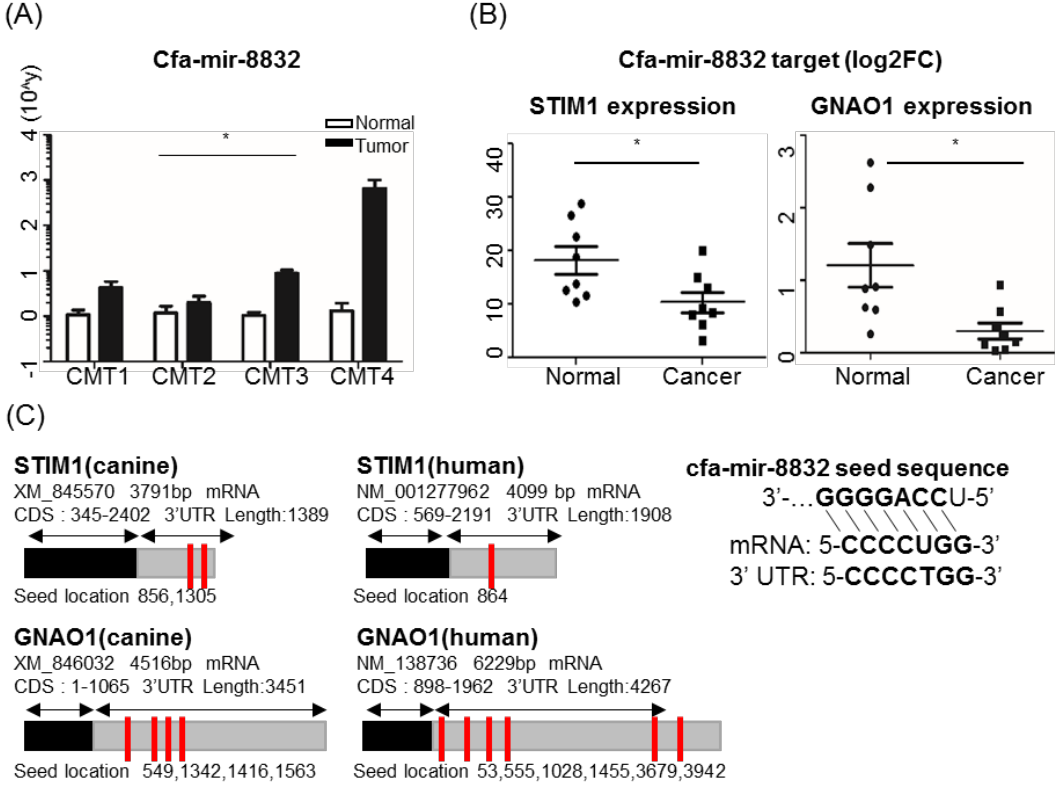
Figure 5. Canine mammary tumor (CMT)–associated miRNA, cfa-mir-8832 expression inversely correlated with the expression of putative target genes, STIM1 and GNAO1 . ( A ) Cfa-mir-8832 expression in CMT and adjacent normal tissues (* p < 0.05). The y -axis represents the 2 Ct value. ( B ) Dot plots of STIM1 and GNAO1 gene expression in CMT and adjacent normal tissues. RPS gene was used as the normalization gene. The y -axis represents log2 fold change value. ( C ) Putative miRNA target sites on STIM1 and GNAO1 orthologous genes in dog (left) and human (right). Gray indicates 3’ untranslated regions. Red lines indicate target loci of miRNA cfa-mir-8832. GGGGACC: seed sequence of cfa-mir-8832.